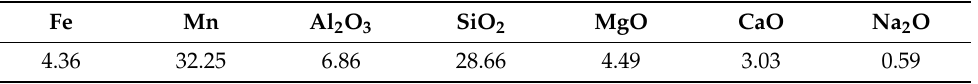
Table 3. Main chemical composition analysis of low-intensity magnetic separation tailings (%).